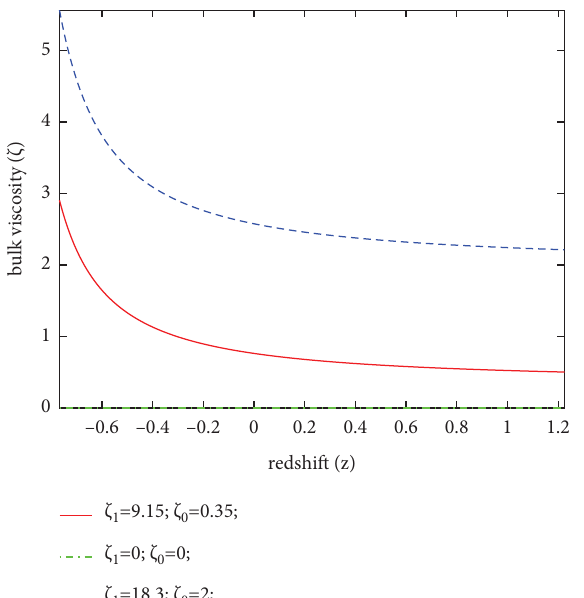
vhde ) versus redshift ( z ) Figure 8: Bulk viscosity ( ζ ) versus redshift ( z ) for BT-VIII.